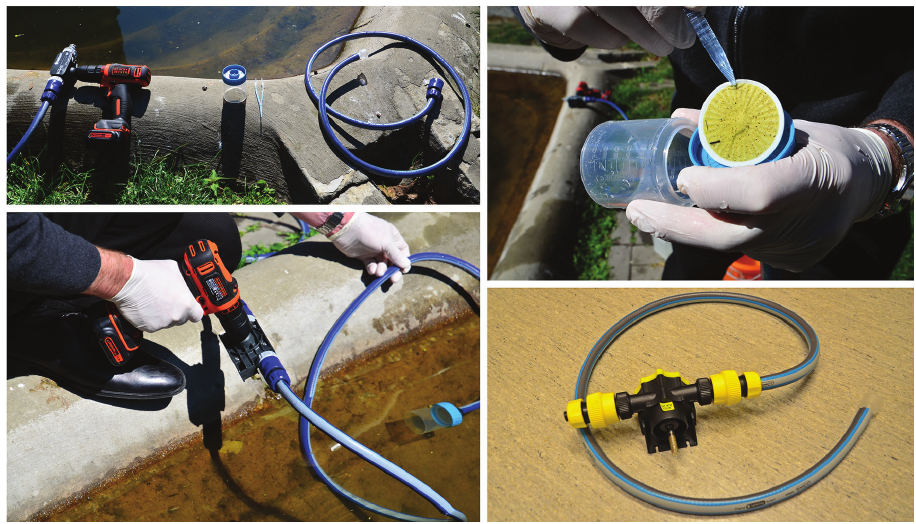
Figure 2. Drill-powered sampling equipment. The low-cost sampling equipment used in this study con- sisting of a drill-powered pump, single use forceps, filter cups and glass fibre filters. The pump depicted in the bottom right corner is one of many alternative models to the one used in this